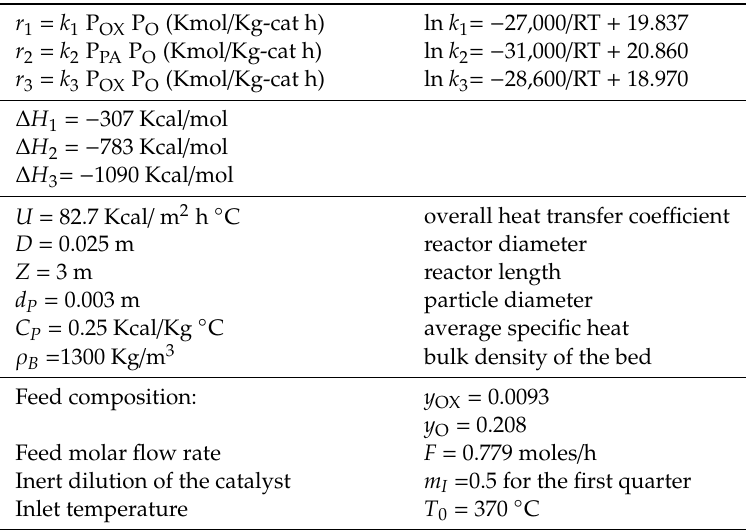
Table 4. Kinetic data for the conversion of o-xylene to phthalic